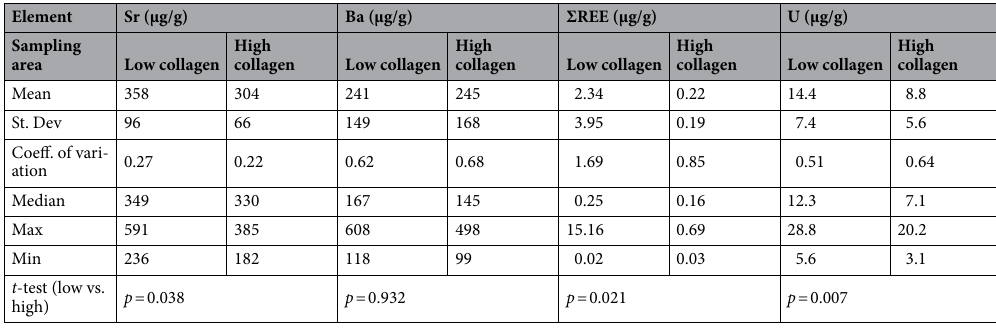
Table 2. Summary statics of LA-ICPMS spot analyses on bone samples (i.e., S37, S40, S2, RSS1, RSS2 and RB38).